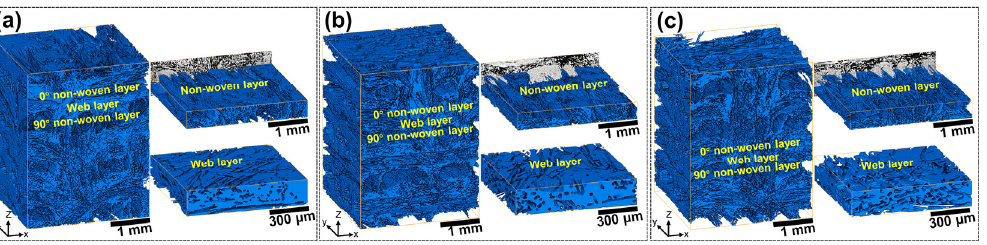
Figure 3. 3D reconstruction graphs of connected pores of the porous C/C composites with various densities: ( a ) C/C-1; ( b ) C/C-2; ( c ) C/C-3.